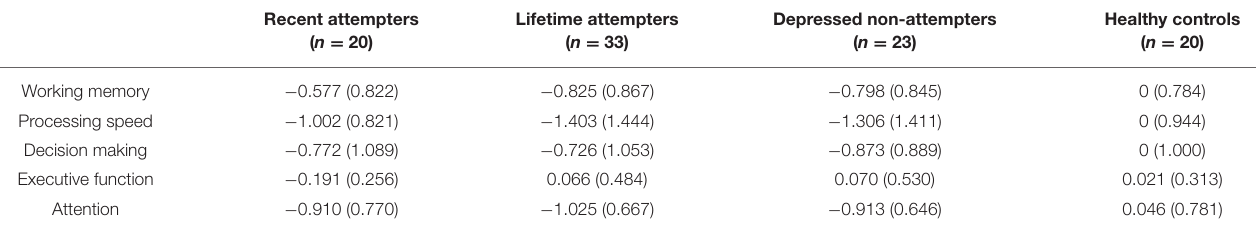
TABLE 3 | Cognitive domains by group a .